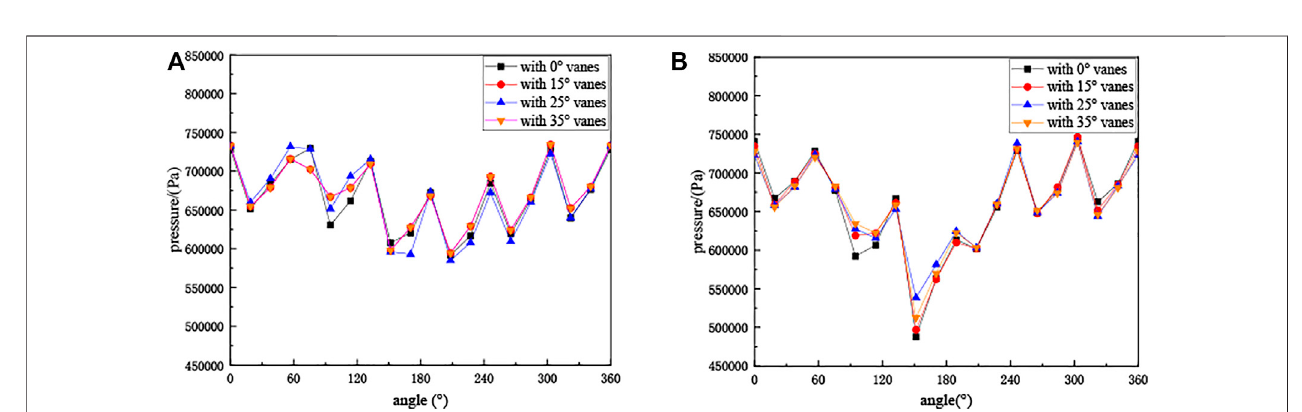
FIGURE 14 | Pressure distribution at the intersection of the volute and impeller: (A) 0.6 Q d and (B) 0.8 Q d .